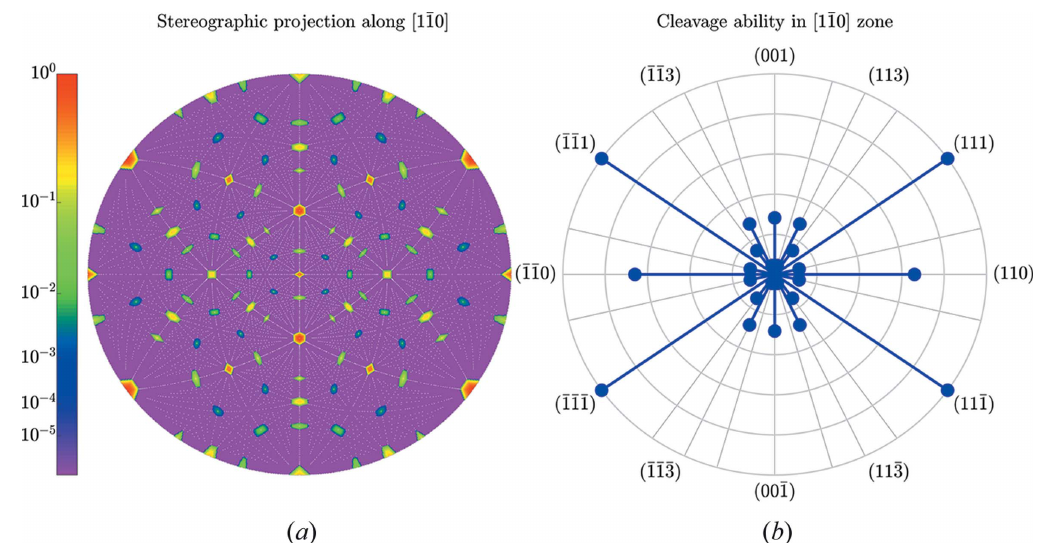
Figure 5 Anisotropy of C hkl values in silicon. ( a ) The stereographic projection viewed along the ½ 1 (cid:4) 110 (cid:7) crystallographic direction displays the false-colour map of the C hkl (dependence of C hkl on the direction). Each point on the stereographic projection corresponds to a specific reciprocal-space direction. The small white points indicate the stereographic projections of the normals to all the lattice planes involved in the calculation. The colour scheme expresses the Þ according to the colour bar on the left. ( b ) The polar diagram of the cleavage ability for all the planes in the ½ 1 (cid:4) 110 (cid:7) zone. The outer = max ð C values C hkl hkl circle corresponds to the highest cleavage ability ( C 111 = 1.025 A˚ for the case of silicon).